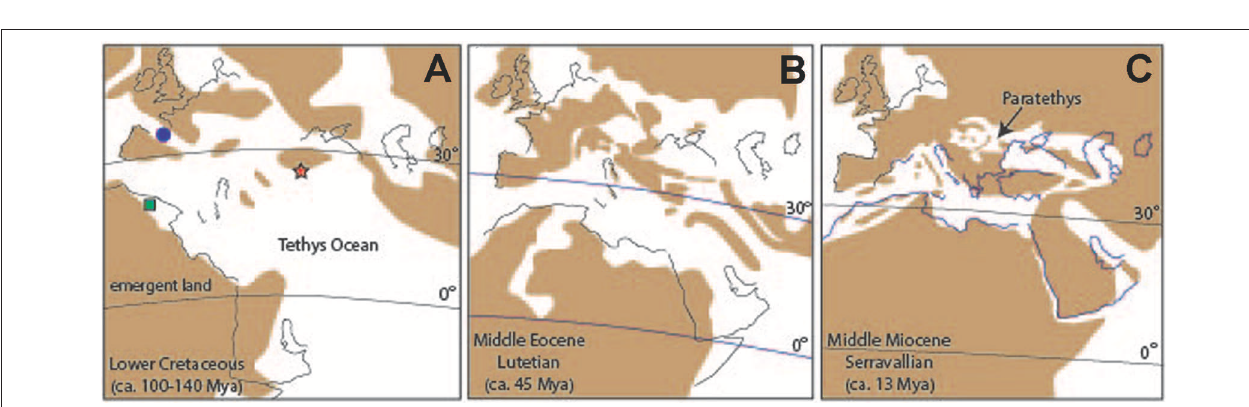
FIGURE 5 | Paleogeographical sketches of the Mediterranean region at three time intervals in the last 140 My. Brown areas: emergent land; white areas: ocean/seas. Black lines: present-day shorelines for geographic reference. Position of Equator (0 ◦ ) and parallel 30 ◦ N at each time. (A,B) The northward movement of Southern Hemisphere crustal plates converging with the Eurasian plates, progressively narrowed and divided the circumtropical Tethys Ocean (modified from Barrier et al., 2018). (C) By the Middle Miocene, the Mediterranean Sea became isolated from the Indo-Pacific and remained connected to the open ocean only at its western end (modified from Rögl, 1998). Location of the first records of Spolithales (red star), Hapalidiales (green square), and Corallinales (blue